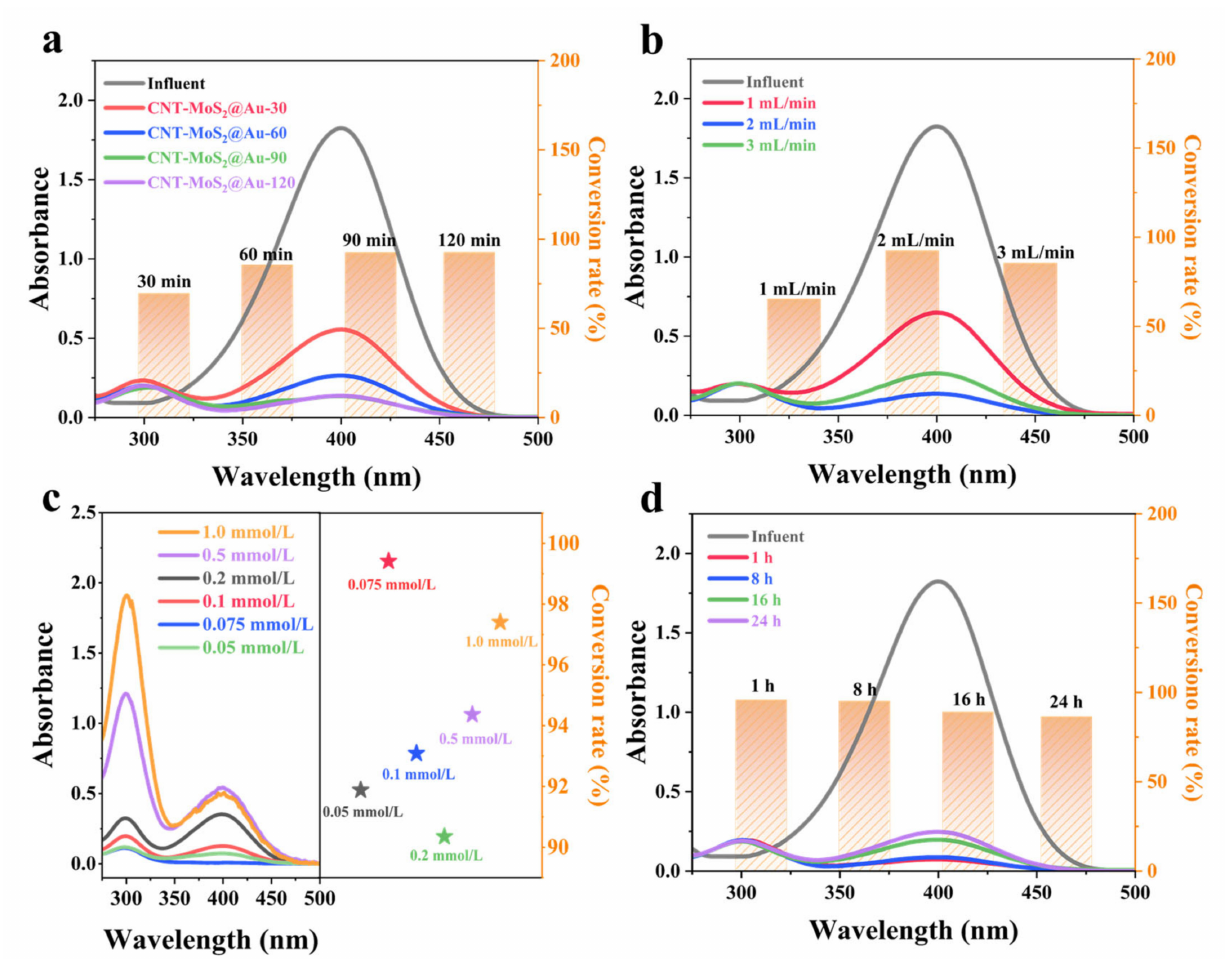
Figure 3. Effects of ( a ) Au loading time (30 to 120 min), ( b ) flow rate (1 to 3 mL/min), and ( c ) initial 4-NP concentration (0.05 to 1.0 mM) on the conversion of 4-NP using the CNT-MoS 2 @Au catalytic membrane. ( d ) Operating stability in the 4-NP reduction using the CNT-MoS 2 @Au catalytic mem- brane (24